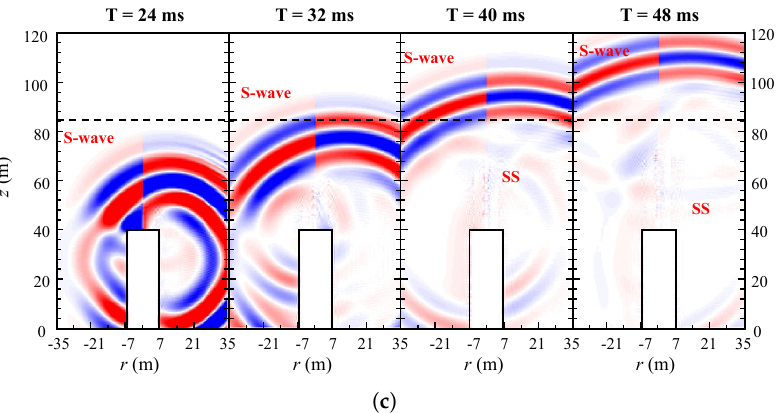
Figure 2. Wavefield in v r component of the model with a single vertical interface at different times. ( a ) 3D wavefield snapshot at different time. Snapshot of ( b ) P -wavefield and ( c ) S -wavefield in ro θ plane at different time.